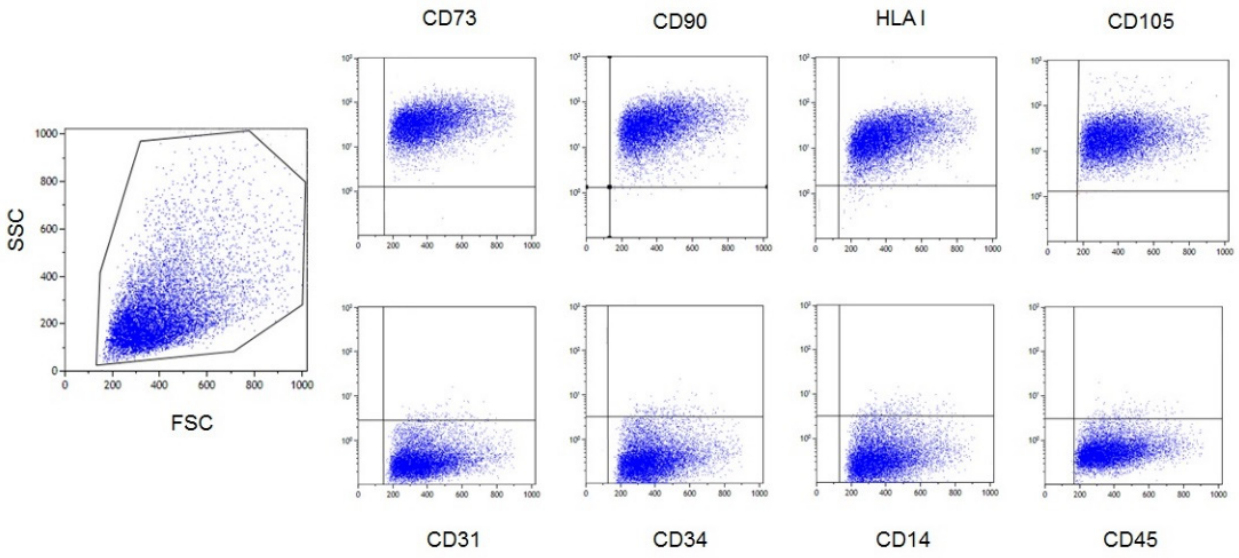
Figure 2. Flow cytometry analysis of one representative MSC lot. Positive markers ( ≥ 95% of the gated cell populations defined by physical parameters) and negative markers ( ≤ 5%) are reported in the upper and lower panels, respectively.